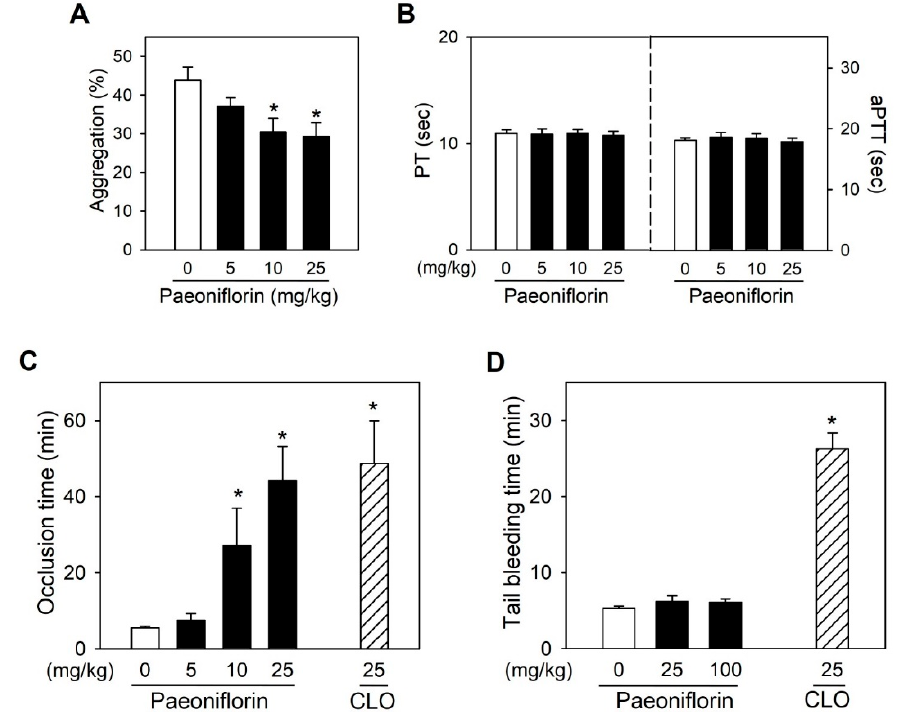
Figure 5. In vivo e ff ects of paeoniflorin on arterial thrombosis and bleeding time. ( A ) Ex vivo e ff ects of paeoniflorin on SIPA in freshly isolated rat platelets, which were collected from SD rats following the intravenous treatment with paeoniflorin for 30 min ( n = 5). ( B ) In vivo e ff ects of paeoniflorin on thrombin time (PT), and activated partial prothrombin time (aPTT) ( n = 5). ( C ) In vivo e ff ects of paeoniflorin on time to occlusion the in rat arterial thrombosis model induced by FeCl 3 ( n = 5). ( D ) E ff ects of paeoniflorin on bleeding time in rat tail transection model. The in vivo e ffi cacy of paeoniflorin was compared to that of clopidogrel (CLO) at the dose of 25 mg / kg by oral administration ( n = 5). Values are mean ± SEM (expressed as the error bar) of at the independent experiments from di ff erent animals. *, significant di ff erences from control group ( p < 0.05).